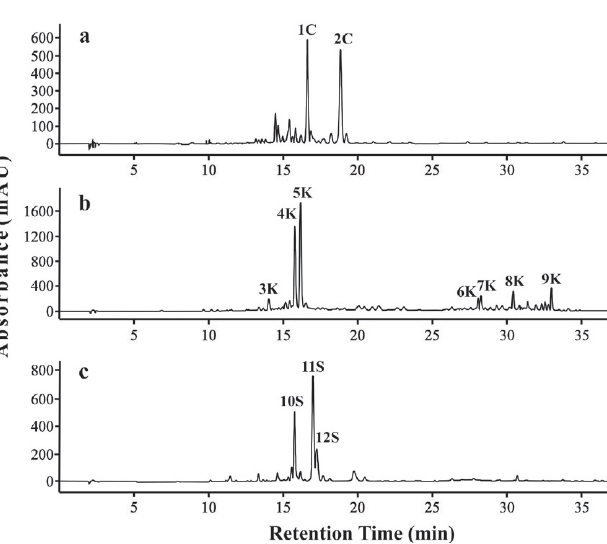
Fig. 2: Comparative HPLC-DAD chromatograms at 320 nm of phenolic profiles in Echeveria species. (a) E. craigiana , (b) E. kimnachii and (c) E. subrigida . The tentative identification of the constituents is shown in Tab.